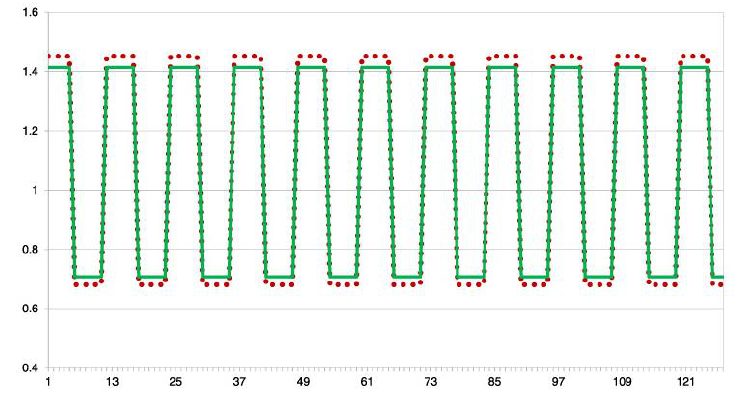
Figure 4. True value of 𝑔 𝑡 (solid line) and their fit (discontinuous line).